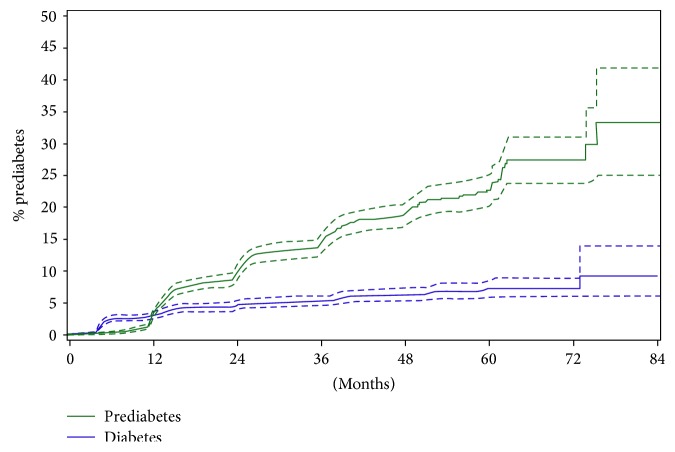
Cumulative risk of diabetes and prediabetes over time since the delivery (+95% CI). The crossing of the two curves is the result of data registration: diabetes may have been detected and registered at 3-month postnatal screening, hence the “bump” around 3 months in the curve for diabetes. Prediabetes was only registered at long-term yearly follow-up with the GP, hence the “bump” around 12 months (and with 12-month intervals thereafter).